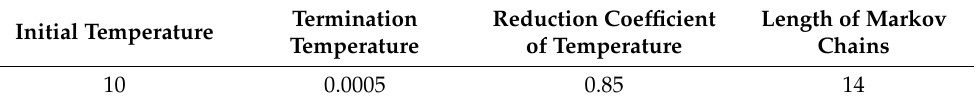
Table 4. Design parameters in the cooling schedule of simulated annealing (SA) algorithm.